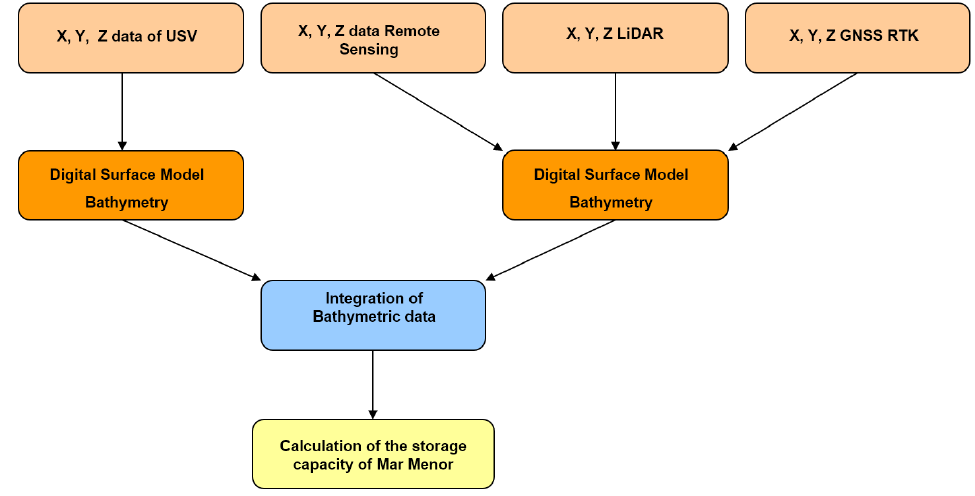
Figure 8. Flowchart showing the integration of the LiDAR and bathymetric data of Mar Menor.